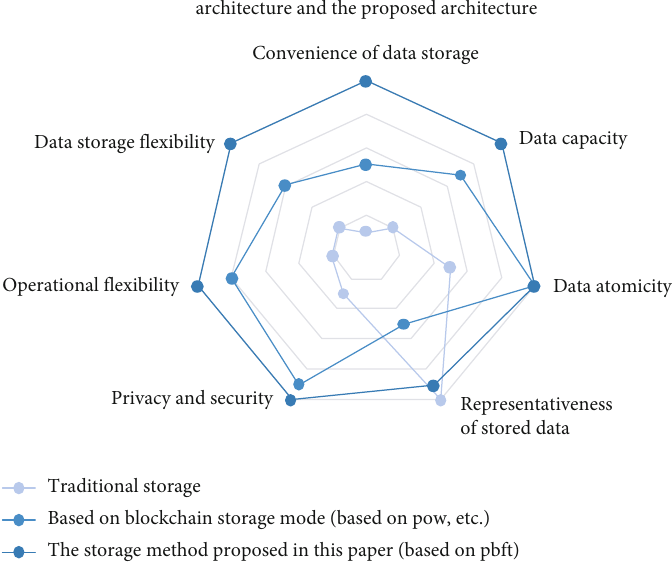
Figure 13: Detailed comparison dimensions and results.